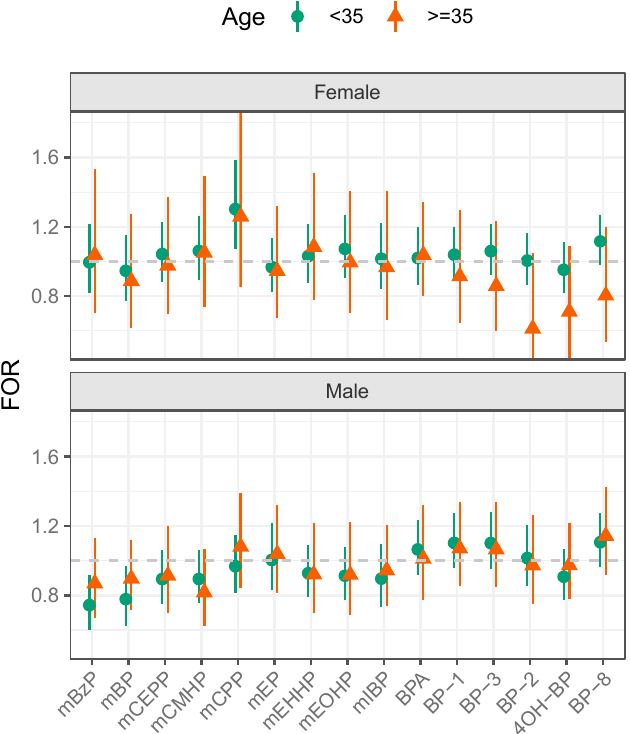
Figure 1. Fecundability odds ratios (FORs) for urinary phthalate metabolites, bisphenol A and benzophenone-type ultraviolet filters by age (<35 to age ≥ 35 years) among participants in the Longi- tudinal Investigation on Fertility and Environment Study in Michigan and Texas (2005–2009). NOTE: monobenzyl phthalate (mBZP), mono-n-butyl phthalate (mBP), mono(2-ethyl-5-carboxylpentyl) phthalate (mCEPP), mono-[(2-carboxymethyl)hexyl] phthalate (mCMHP), mono(3-carboxypropyl) phthalate (mCPP), monoethyl phthalate(mEP), mono(2-ethyl-5-hydroxyhexyl) phthalate (mEHHP), mono(2-ethyl-5-oxohexyl) phthalate (mEOHP), mono(2-isobutyl phthalate (miBP), bisphenol A (BPA), 4-hydroxybenzophenone (4OH-BP), benzophenone 1 (BP-1), benzophenone 2 (BP-2), benzophenone 3 (BP-3), benzophenone 8 (BP-8). Models were adjusted for age (years), urinary creatinine (mg/dL), serum cotinine (>10 ng/mL vs. ≤ 10 ng/mL), and BMI (kg/m 2 ). Table 3. Fecundability odds ratios (FORs) for urinary phthalate metabolites, bisphenol A, and ben- zophenone-type ultraviolet filters by age (<35 to age ≥ 35 years) among participants in the Longitu- dinal Investigation on Fertility and Environment Study in Michigan and Texas (2005–2009).